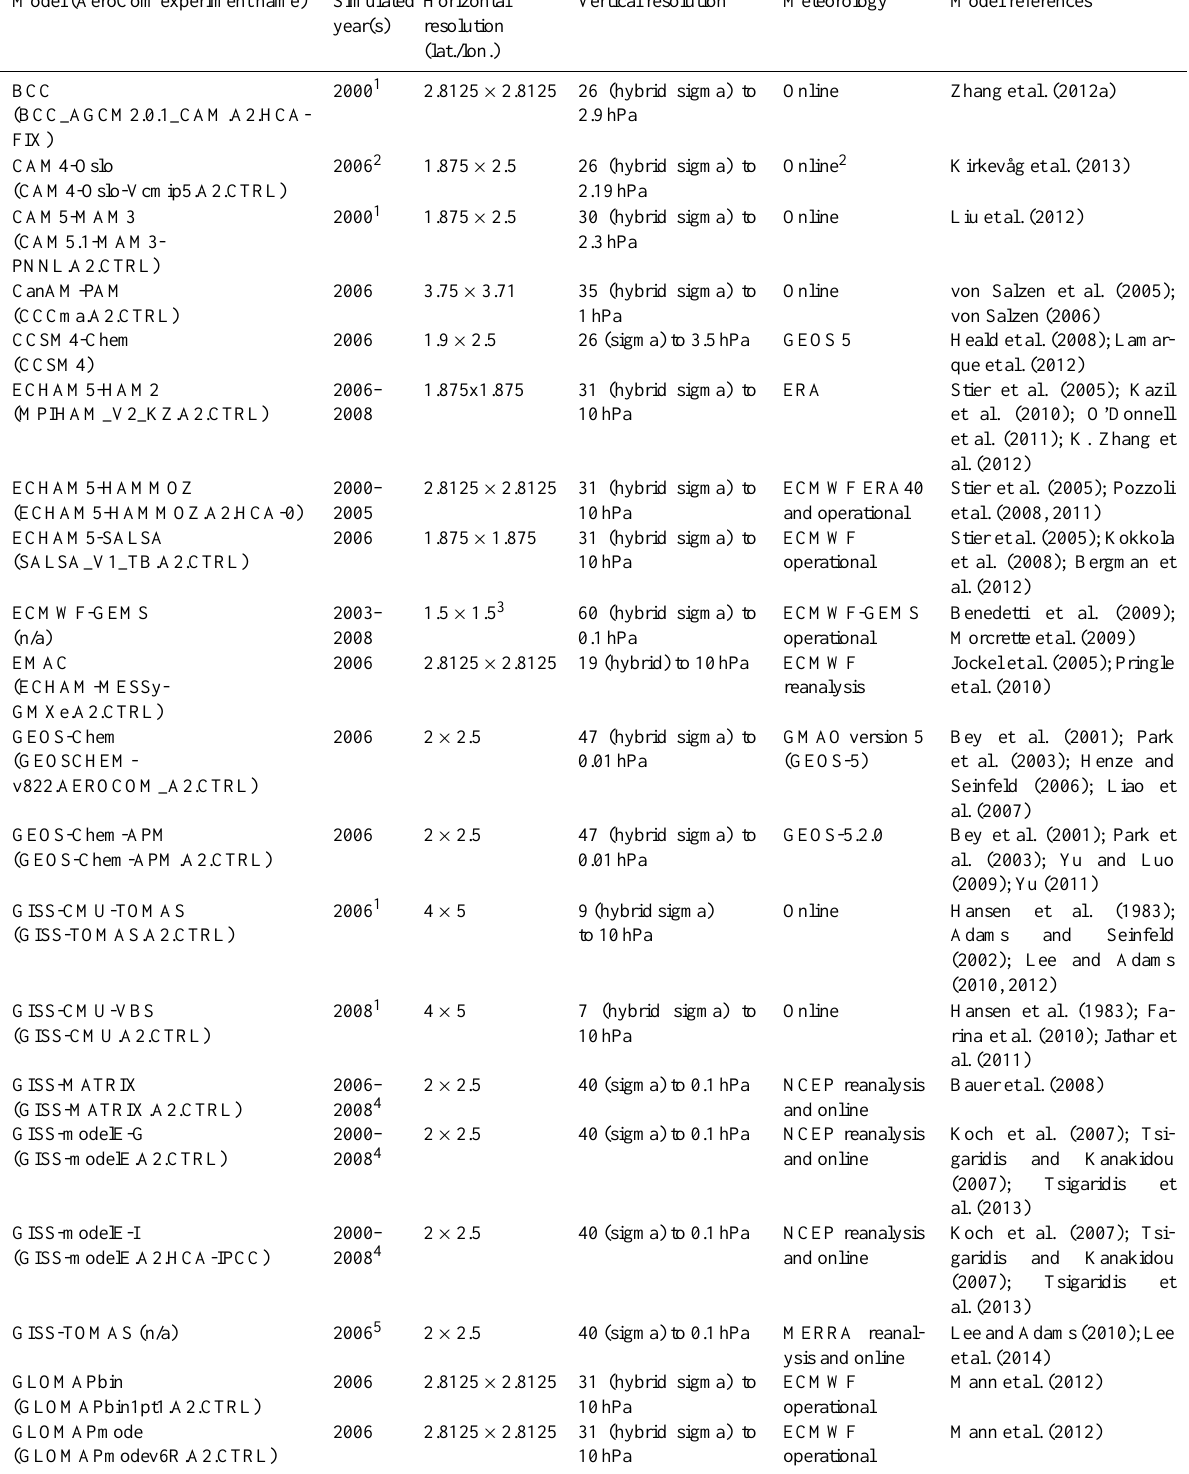
Table 3. Host model description and year of simulation. If multiple years were simulated, the data used for the present study are those from the year 2006, if available; otherwise, the year closest to 2006 was